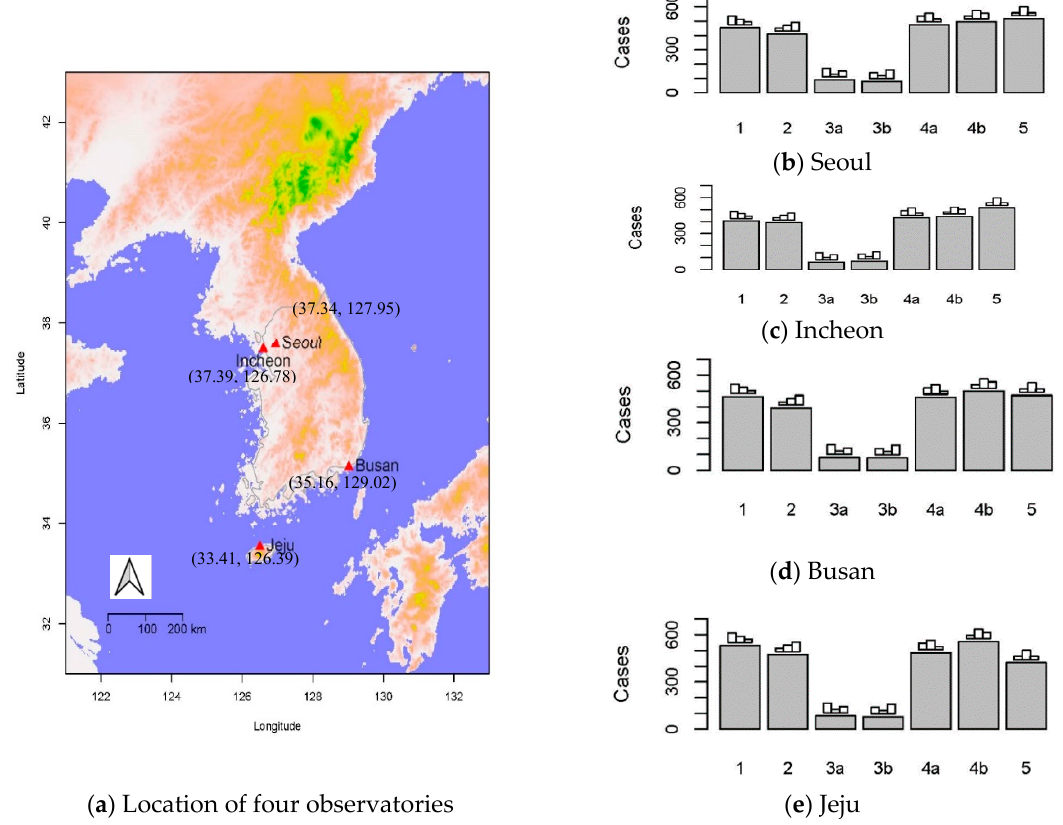
Figure 3. ( a ) Four observatories located in the South Korea (Latitude (°), Longitude (°)) and ( b – e ) the number of observed rainfall patterns in daily rainfall. Lower decreasing (3a) and increasing (3b) patterns has the smallest cases in South Korea.